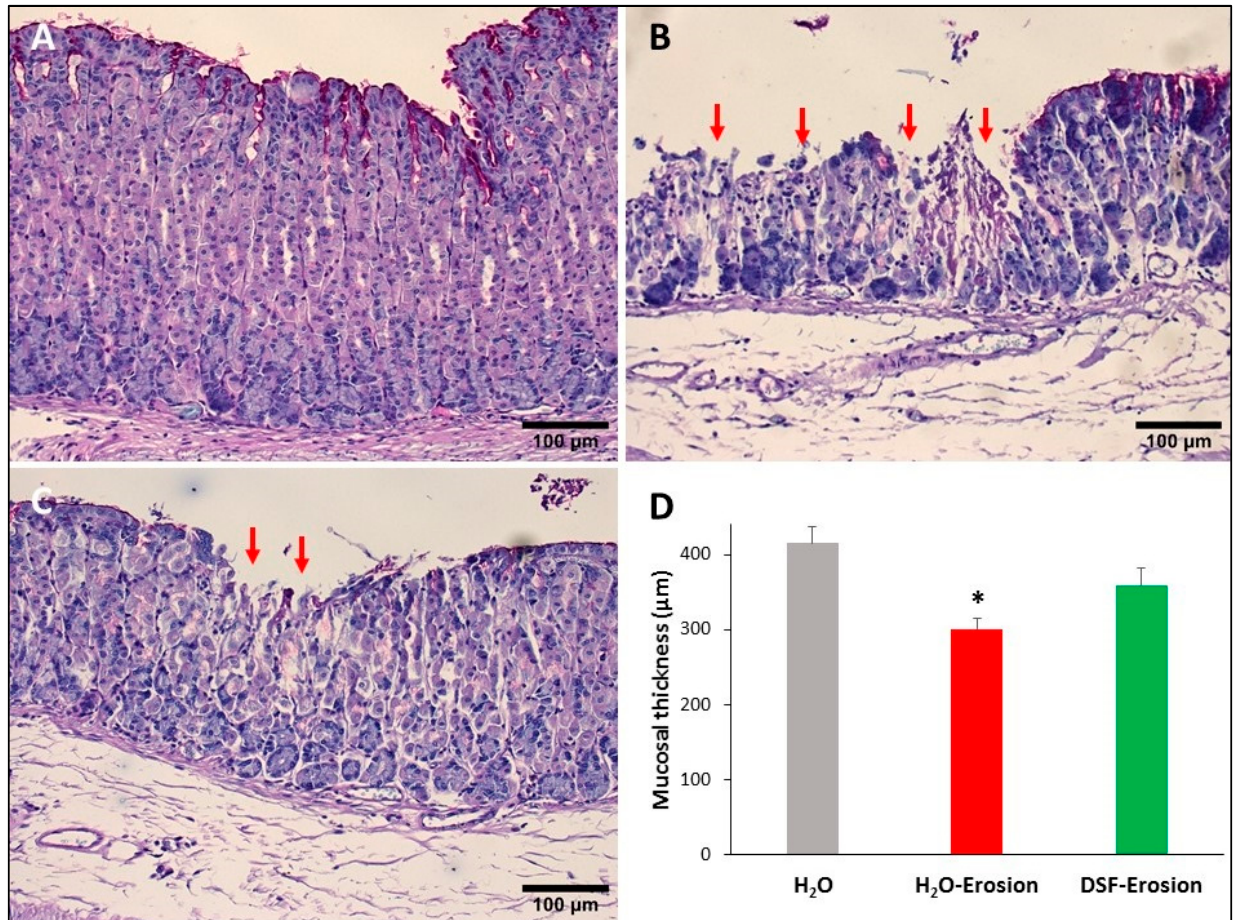
Figure 3. PAS-stained gastric mucosae of H 2 O control ( A ), erosion-induced ( B ) and DSF-pretreated then erosion-induced ( C ) mice. The red arrows in ( B ) and ( C ) are pointing to mucosal erosions. Note that the area of erosion is smaller in ( C ) than in ( B ). ( D ) Measurements of the gastric mucosal thickness in control, erosion-induced and DSF-pretreated erosion-induced mice. Data are presented from 3 animals per group as mean ± SE. Comparing the groups shows significance only between H 2 O-erosion and the H 2 O control. * p < 0.05; scale bar = 100 µm.